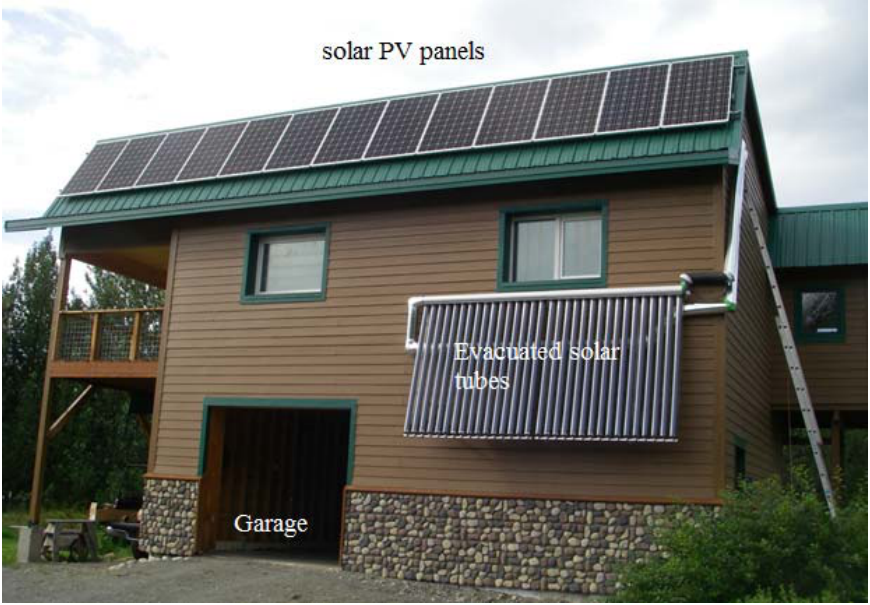
Figure 1. The experimental home in Palmer, Alaska.